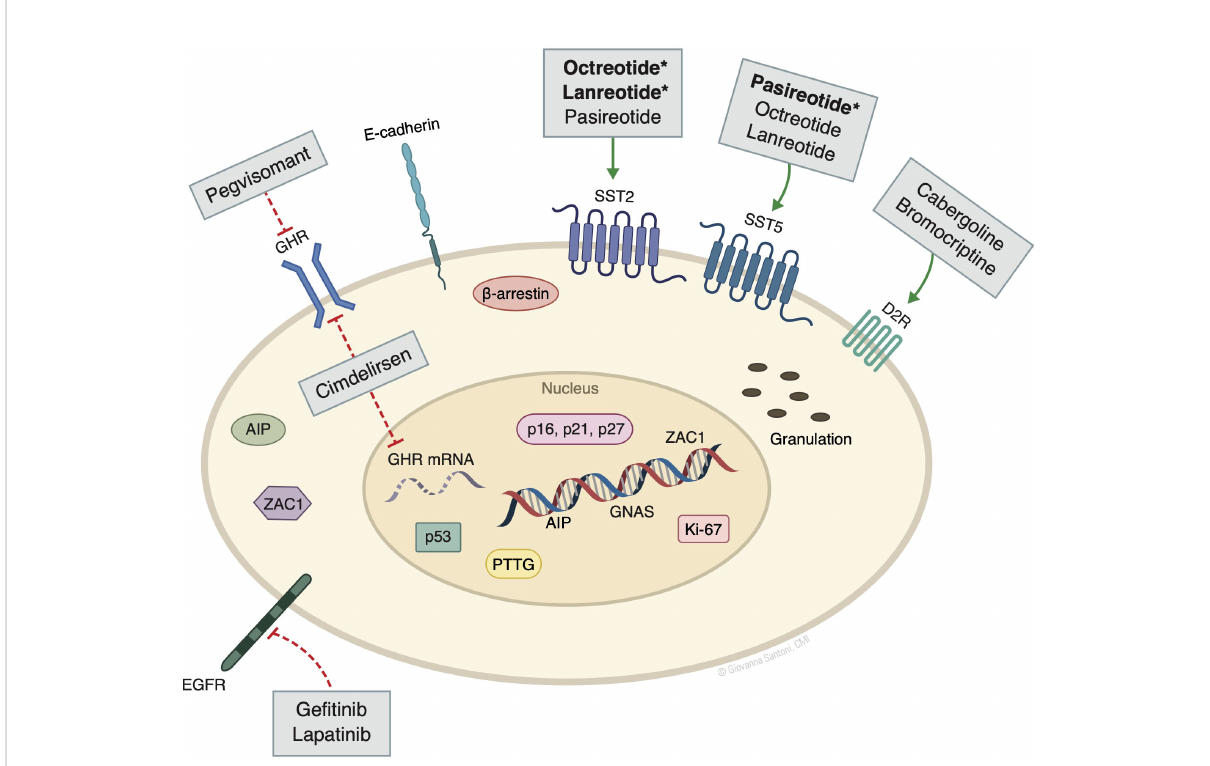
FIGURE 1 Molecular markers and targeted drugs. AIP, aryl hydrocarbon receptor-interacting protein; D2R, dopamine receptor subtype 2; GHR, growth hormone receptor; GNAS, guanine nucleotide binding protein, alpha stimulating activity polypeptide 1 gene. SST, somatostatin receptor; PTTG, pituitary tumor – transforming protein; ZAC1, zinc fi nger regulator of apoptosis and cell cycle arrest. Bolded * denotes the higher/predominant af fi nity of drug to receptor. The action of pegvisomant on GHR is mainly peripheral and not in the pituitary. © Giovanna Santoni, CMI. Used by